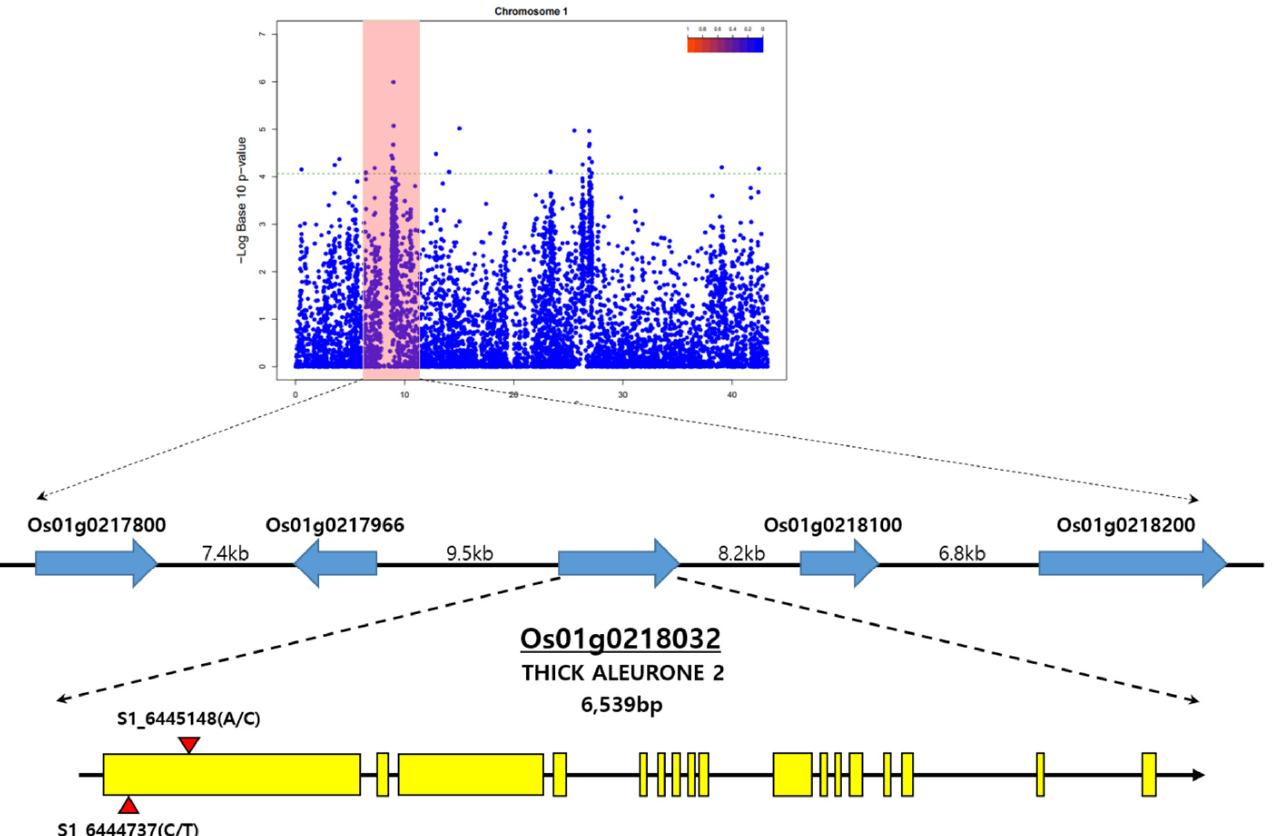
Figure 7. Haplotype analysis of the sequence covering the candidate gene Os01g0218032 on chro- mosome 1 coding regions in the 294 rice core collection and the phenotypic variation among differ- ent haplotypes. *, significant difference at p < 0.05; **, significant difference at p < 0.01; ***, significant difference at p < 0.001.